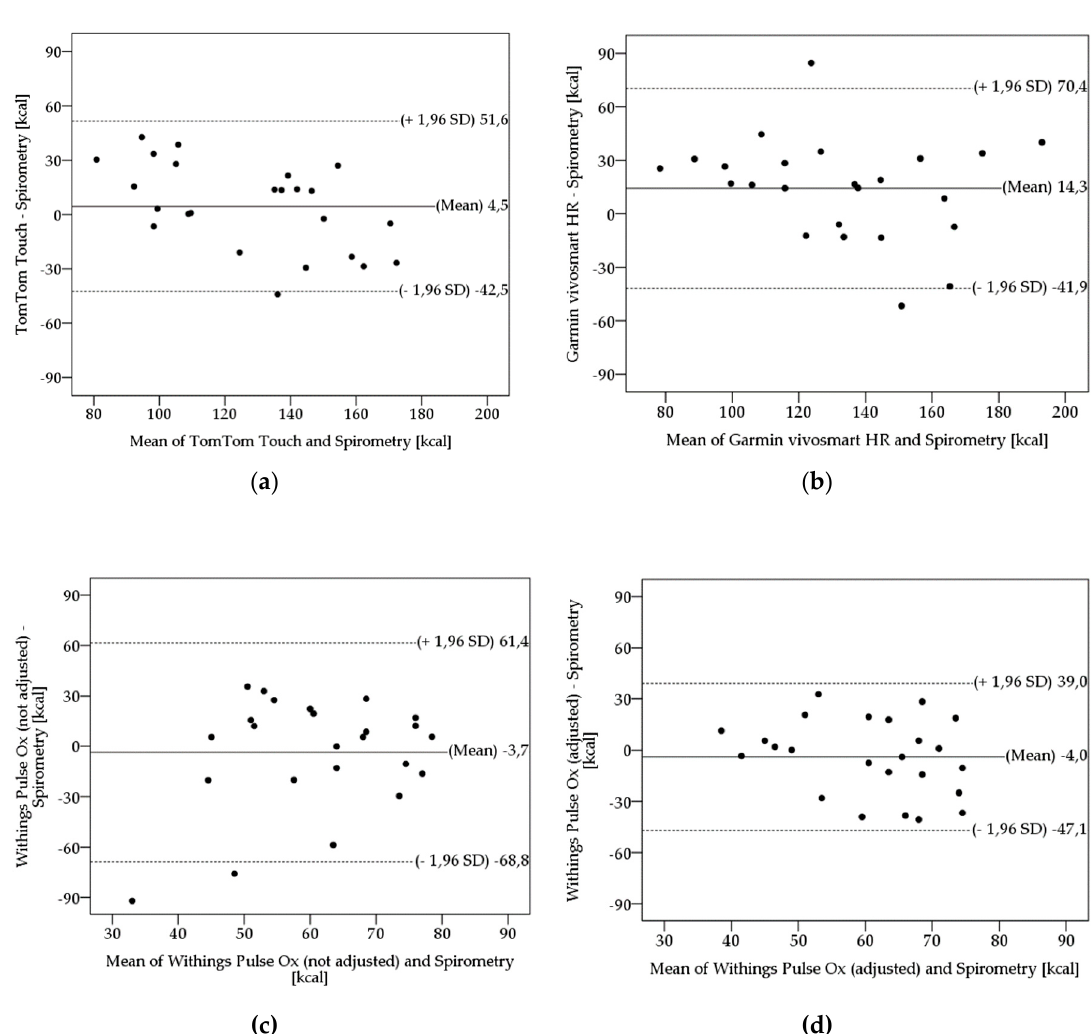
Figure 2. Bland-Altman plots of Spirometry EE for ( a ) TomTom Touch, ( b ) Garmin vivosmart HR, ( c ) Withings Pulse O x (not adjusted), ( d ) Withings Pulse O x (adjusted). Limits of agreement (LoA) were calculated as mean ± 1.96 x SD. Mean biases are depicted as solid line; LoA are depicted as dashed lines. The plots indicate the di ff erences of the EE values on the y-axis relative to the mean of the two methods (spirometry and alternative method) on the x-axis. Mean di ff erences (bias) between estimated EE and EE of spirometry, upper and lower limits of agreement (ULoA, LLoA) are labeled in the plots. Limits of agreement (LoA) were calculated as means ± 1.96 x SD. The fitness trackers show